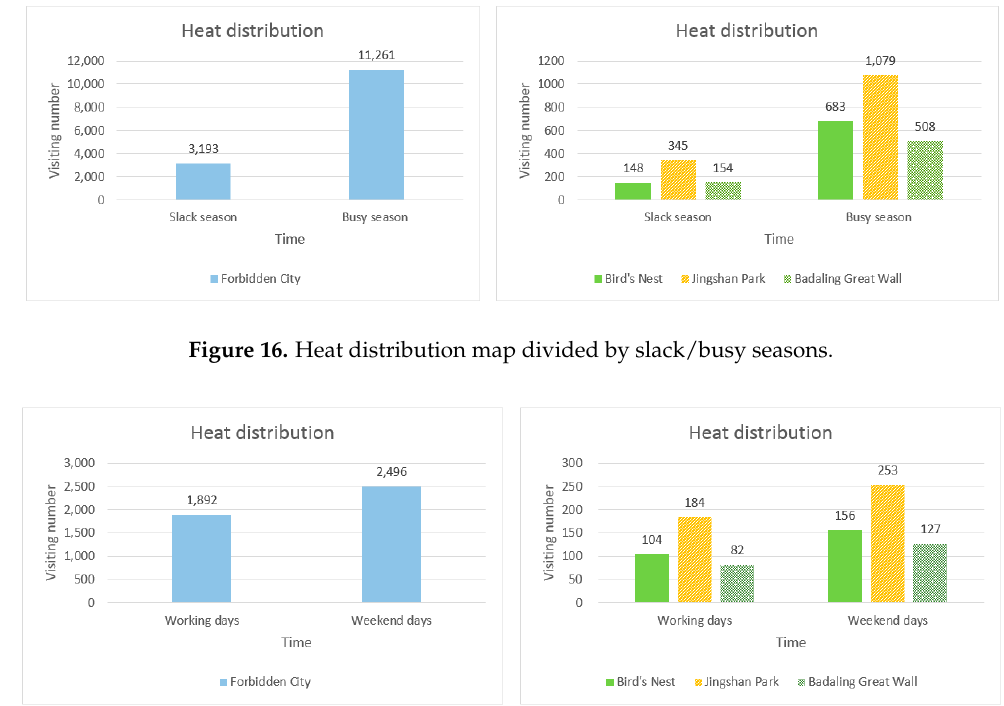
Figure 17. Heat distribution map divided by working/weekend days.